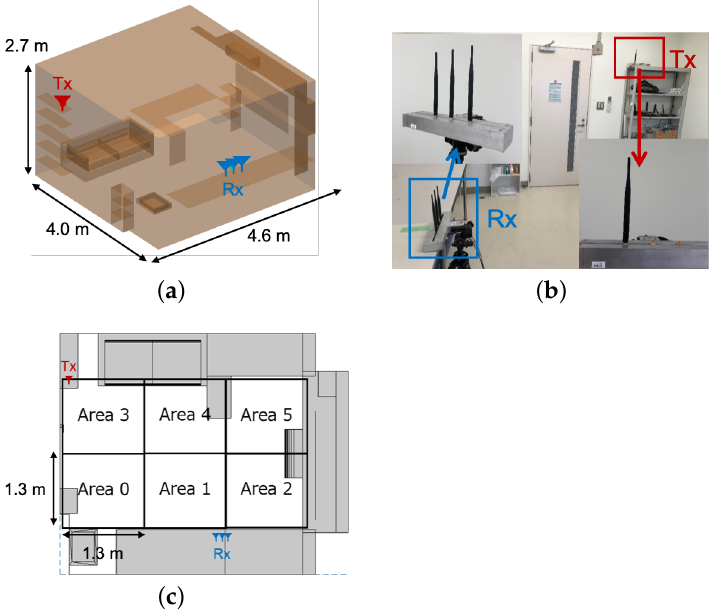
Figure 9. Small office condition. ( a ) Room model. ( b ) Antenna position. ( c ) Defined